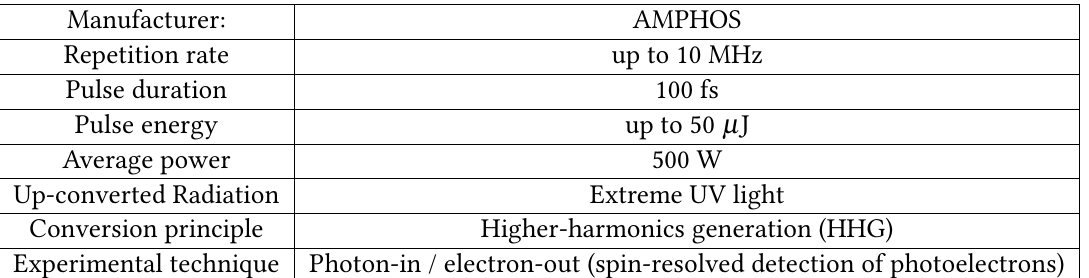
Table 3: Main parameters of Ju